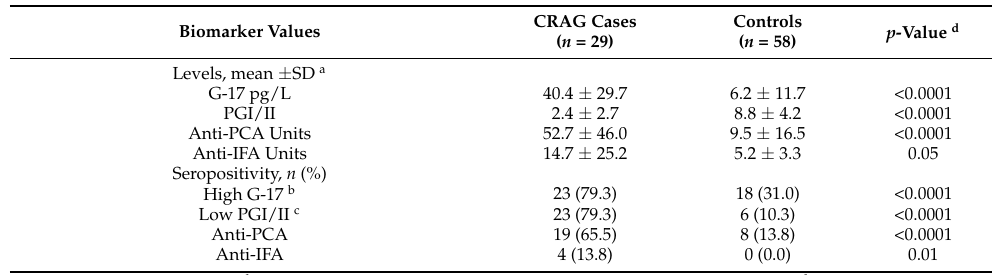
Table 2. Levels of gastrin-17, anti-parietal cell antibodies (anti-PCA), anti-intrinsic factor antibodies (anti-IFA), and pepsinogen ratio (PGI/II) in corpus-restricted atrophic gastritis (CRAG) patients and controls; seroprevalence of biomarkers in CRAG and controls.